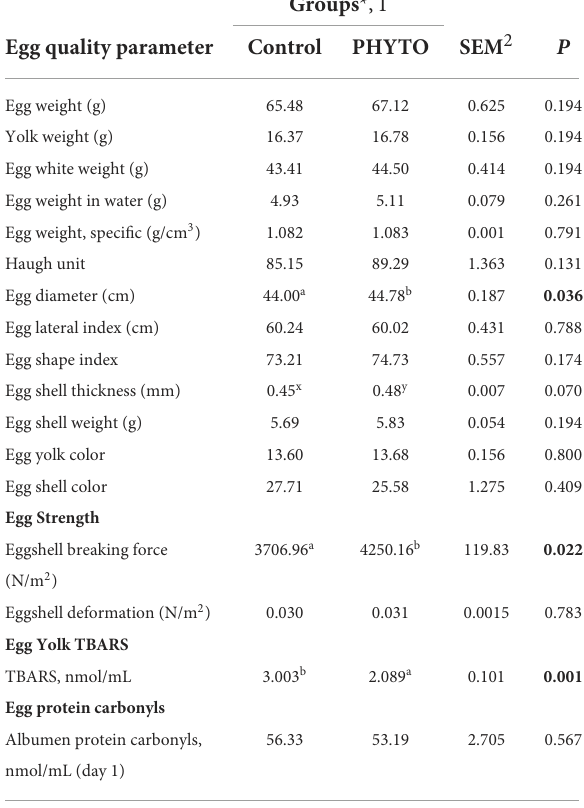
TABLE 5A Effect of dietary supplementation with PHYTO product on TABLE 5B Effect of dietary supplementation with PHYTO on egg egg quality parameters at the 1st week of the trial. quality parameters at the 8th week of the trial. Groups *, 1 Groups *,